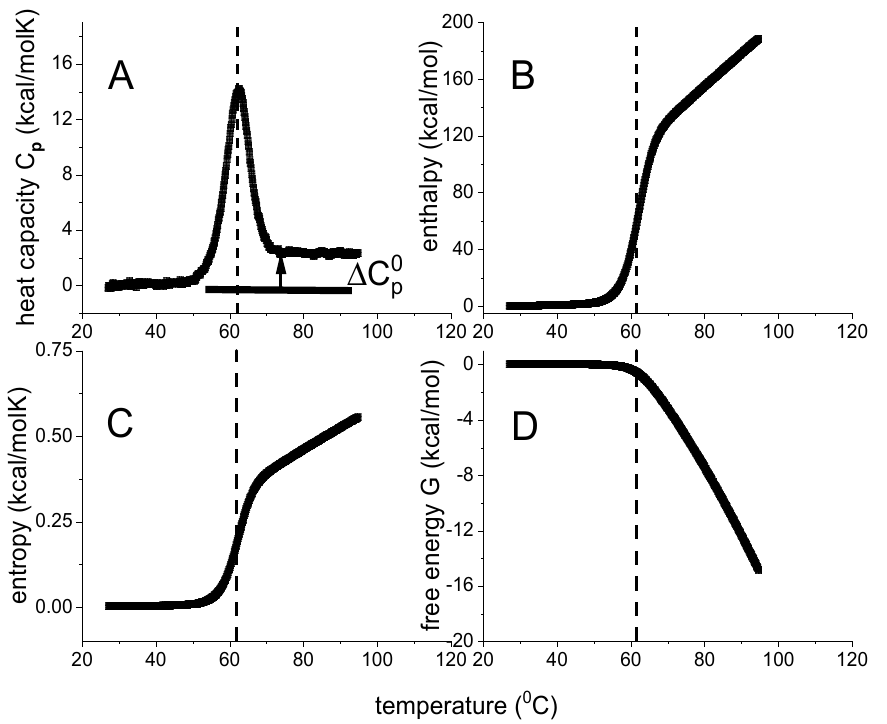
Figure 1. DSC of lysozyme. Model–independent thermodynamic analysis (50 µ M, 20% glycine buffer, pH 2.5). ( A ) Heat capacity. DSC data (temperature resolution 0.17 ◦ C) taken from reference [19,20]. ( B ) Enthalpy Δ H DSC (T) (Equation (1)). ( C ) Entropy Δ S DSC (T) (Equation (2)). ( D ) Gibbs free energy Δ G DSC (T) (Equation (3)).